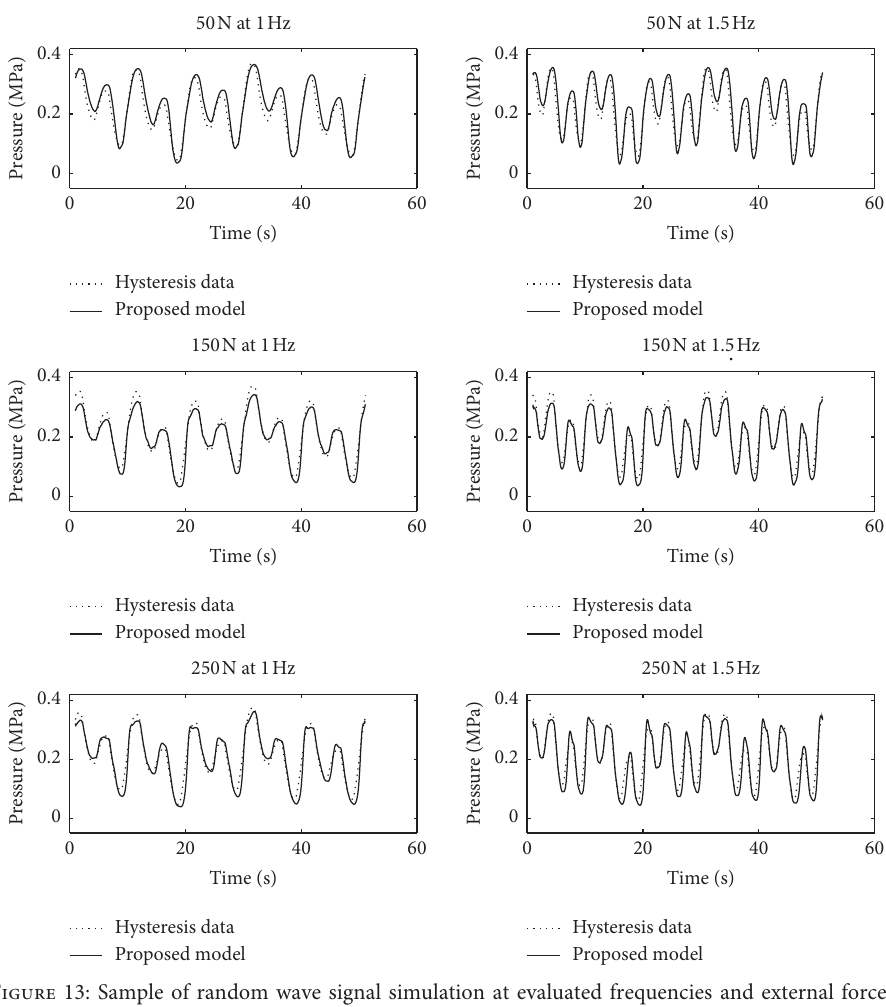
Figure 13: Sample of random wave signal simulation at evaluated frequencies and external